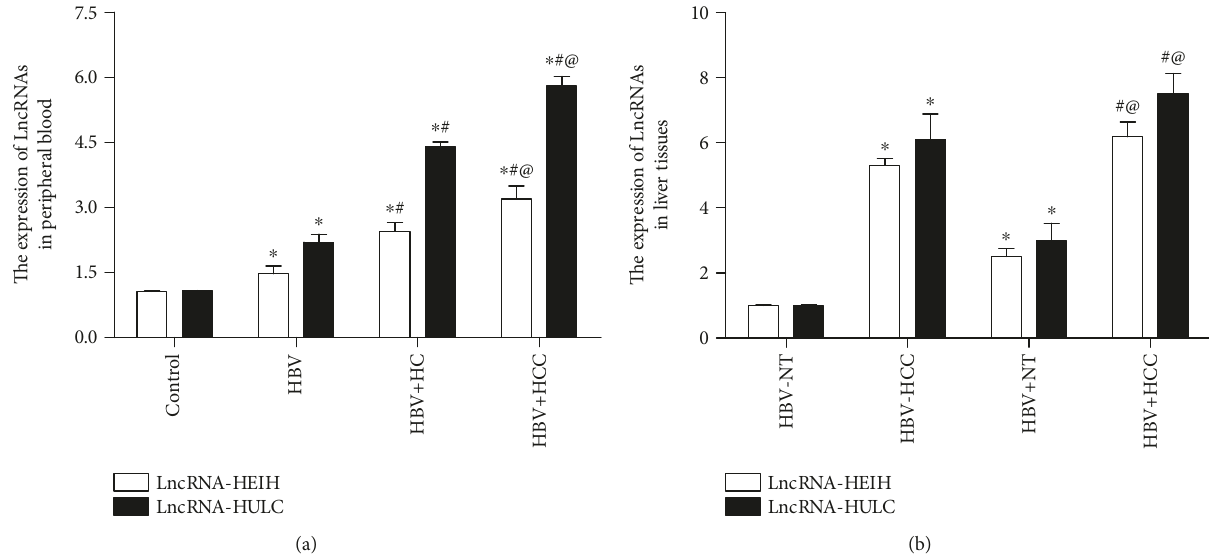
Figure 1: Expression patterns of LncRNA-HEIH and LncRNA-HULC in peripheral blood and liver tissues. (a) Expression levels of LncRNA- HEIH and LncRNA-HULC in peripheral blood ( n = 25 per group). ∗ p < 0 05 vs. the control group; # p < 0 05 vs. the HBV group; p < 0 05 vs. the HBV+ HC group. (b) The expression levels of LncRNA-HEIH and LncRNA-HULC in liver tissues ( n = 25 per group). ∗ p < 0 05 vs. the HBV-NT group; # p < 0 05 vs. the HBV+ NT group; p < 0 05 vs. the HBV-HCC group.